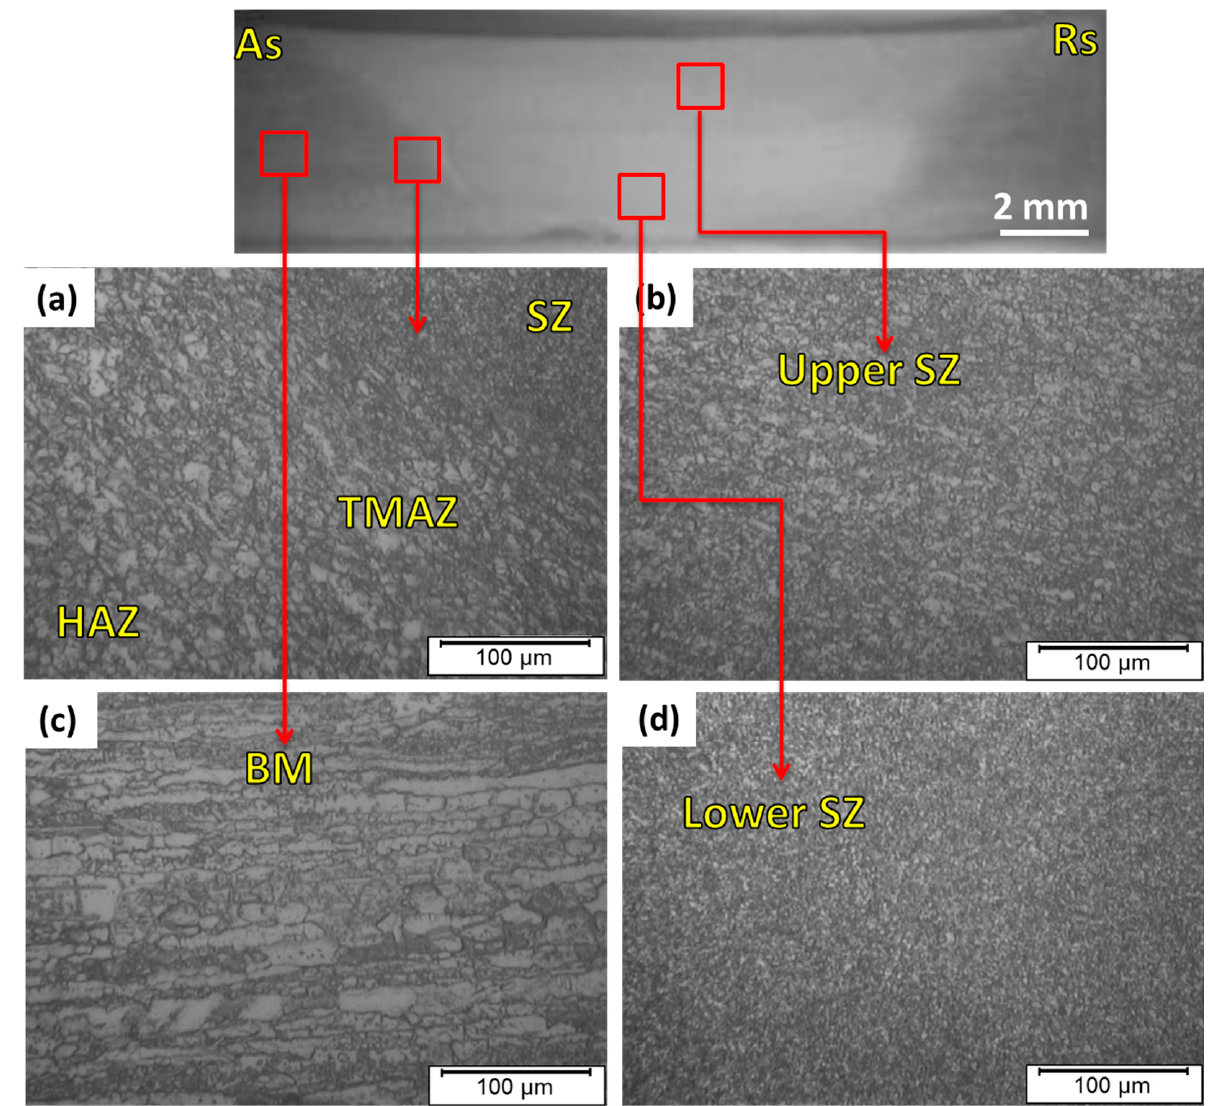
Figure 7. ( a ) Macrograph and ( b – d ) microstructure images of the different zones for the FSWed butt joint of 2205 DSS welded at 300 rpm, 25 mm/min, and 20 KN.